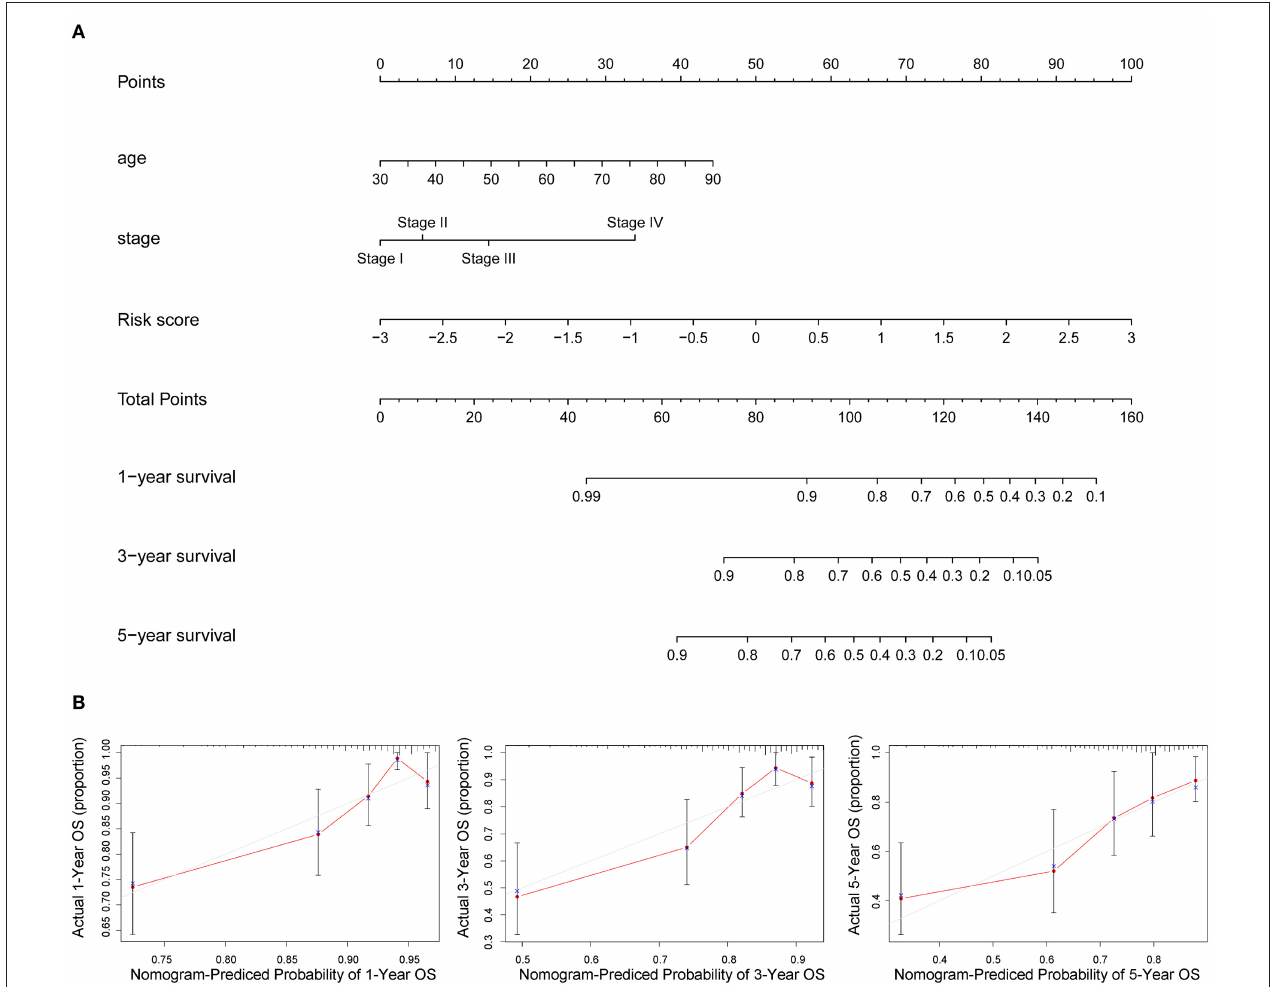
FIGURE 5 | Prognostic nomogram incorporating the risk score model and clinicopathological characteristics. (A) The nomogram of age, stage, and risk score for predicting 1-, 3-, and 5-year survival. (B) The 1-, 3-, and 5-year calibration curves of TCGA